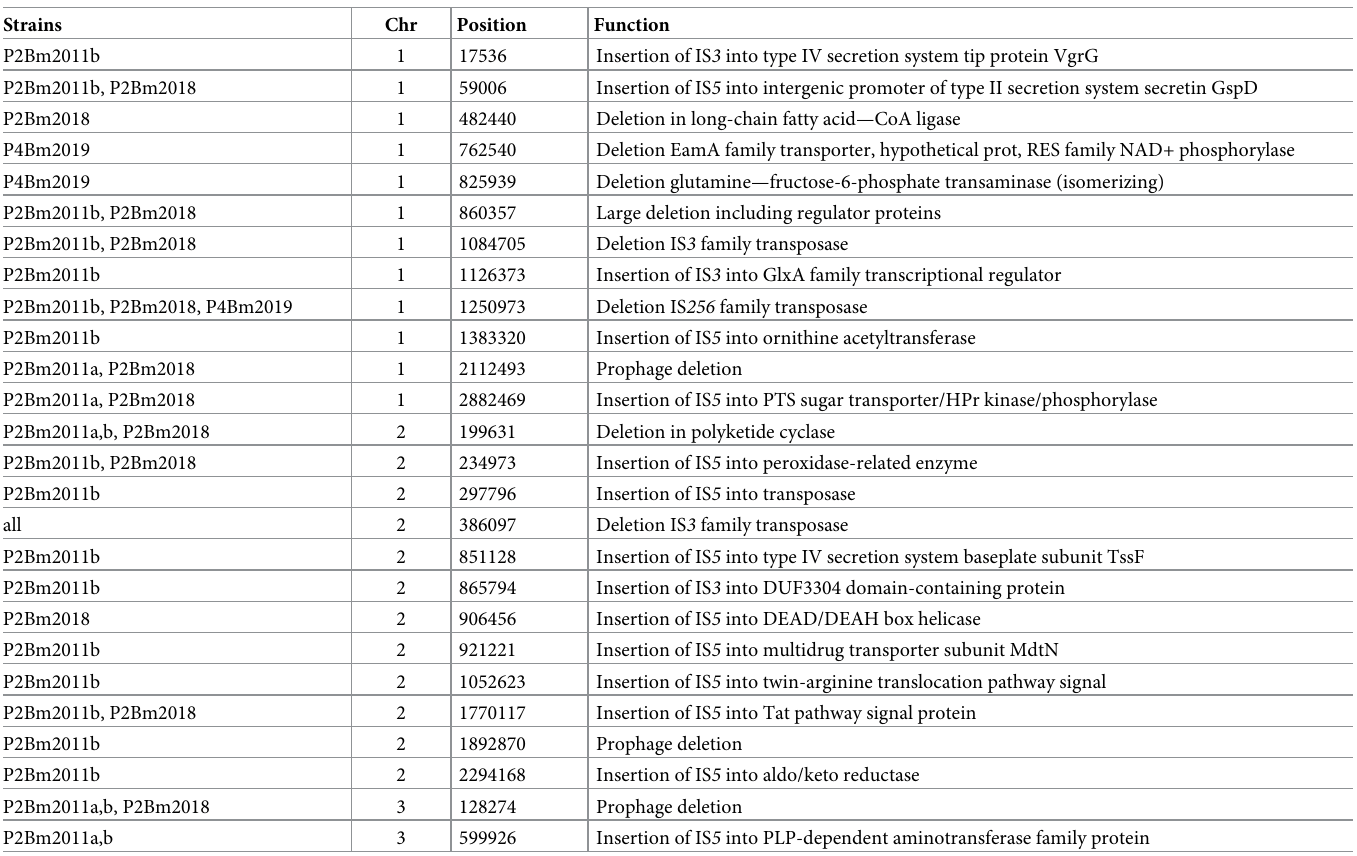
Table 2. Large structural variations in the isolates of Patient 2–4. By setting the isolate P1Bm2009 as a reference, we mapped the long Nanopore reads of the isolates from patients 2 to 4 to identify large structural variations that escape SNPs analysis. We omitted from this list indels found in intergenic regions (11) and hypothetical pro- teins (8). The full list of structural variations can be found in Tables G and H in S1 Tables.